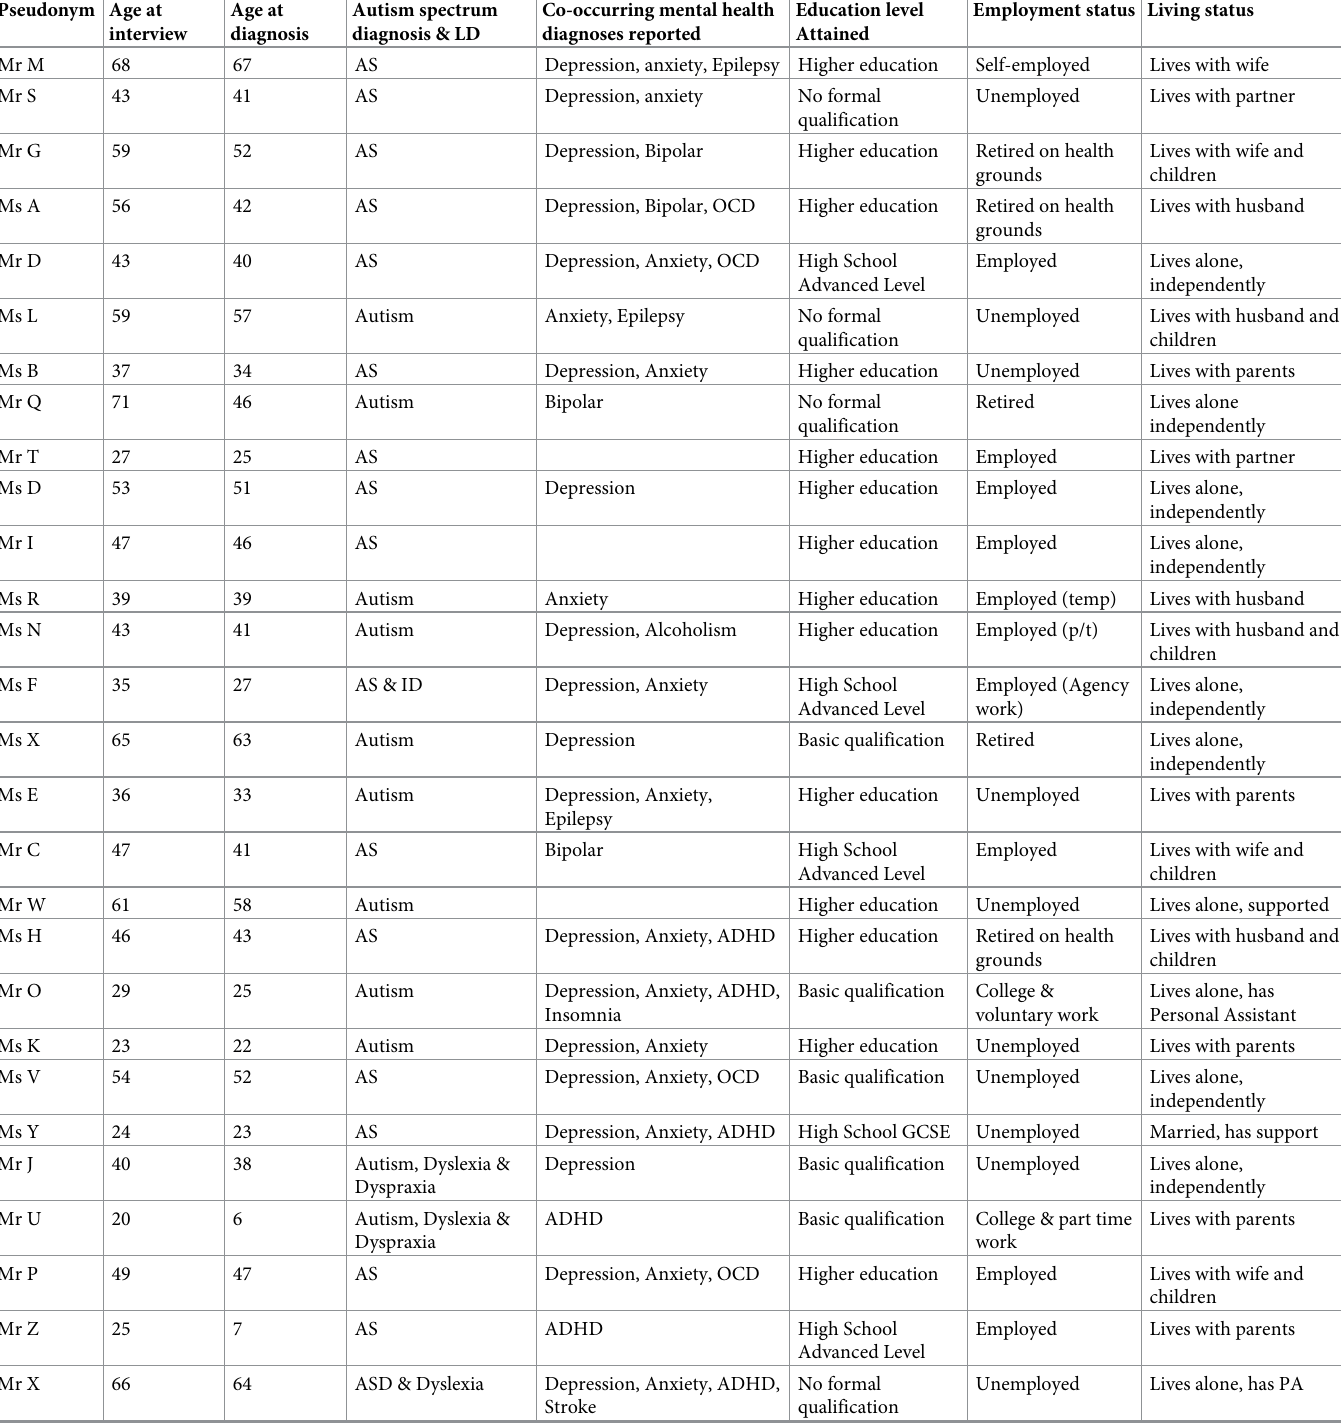
Table 1. Participant characteristics–autistic